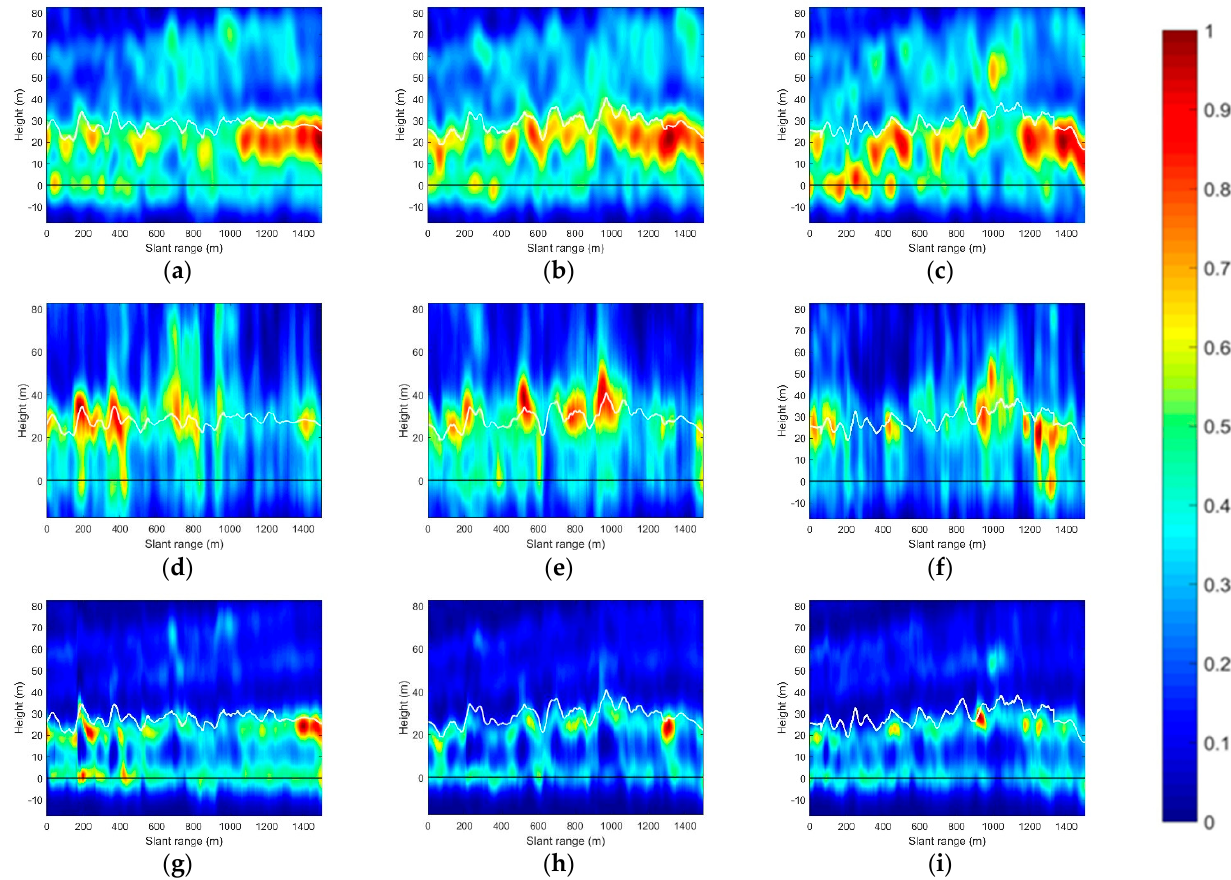
Figure 12. TomoSAR vertical profile of Beamfroming, Capon, and MUSIC. The white curve in vertical profile is LiDAR forest height product (CHM) and the black line in vertical profile is altitude of 0 m. (The top panels are imaging results of Beamforming, the middle panels imaging results of Capon, and the low panels are imaging results of MUSIC; the ( a , d , g ) are imaging results of 100 row in SLC image, the ( b , e , h ) are imaging results of 200 row in SLC image, the ( c , f , i ) are imaging results of 500 row in SLC